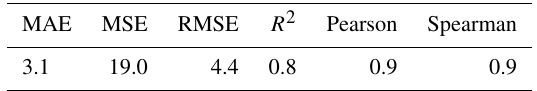
Table 4. The values of validation measures between predicted and observed